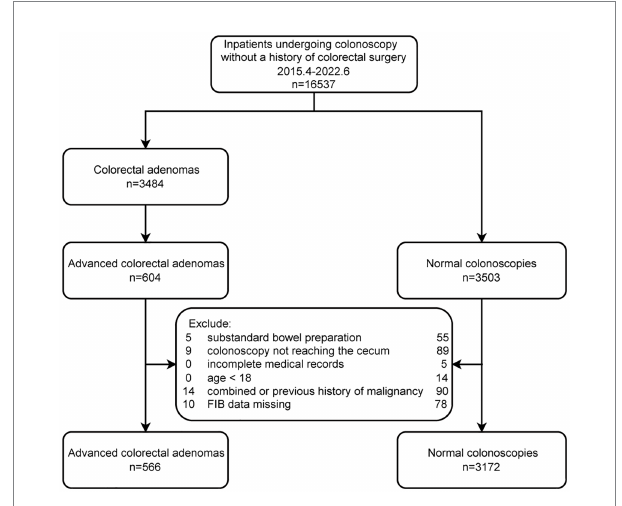
FIGURE 1 Flow diagram of the screening and enrollment of study